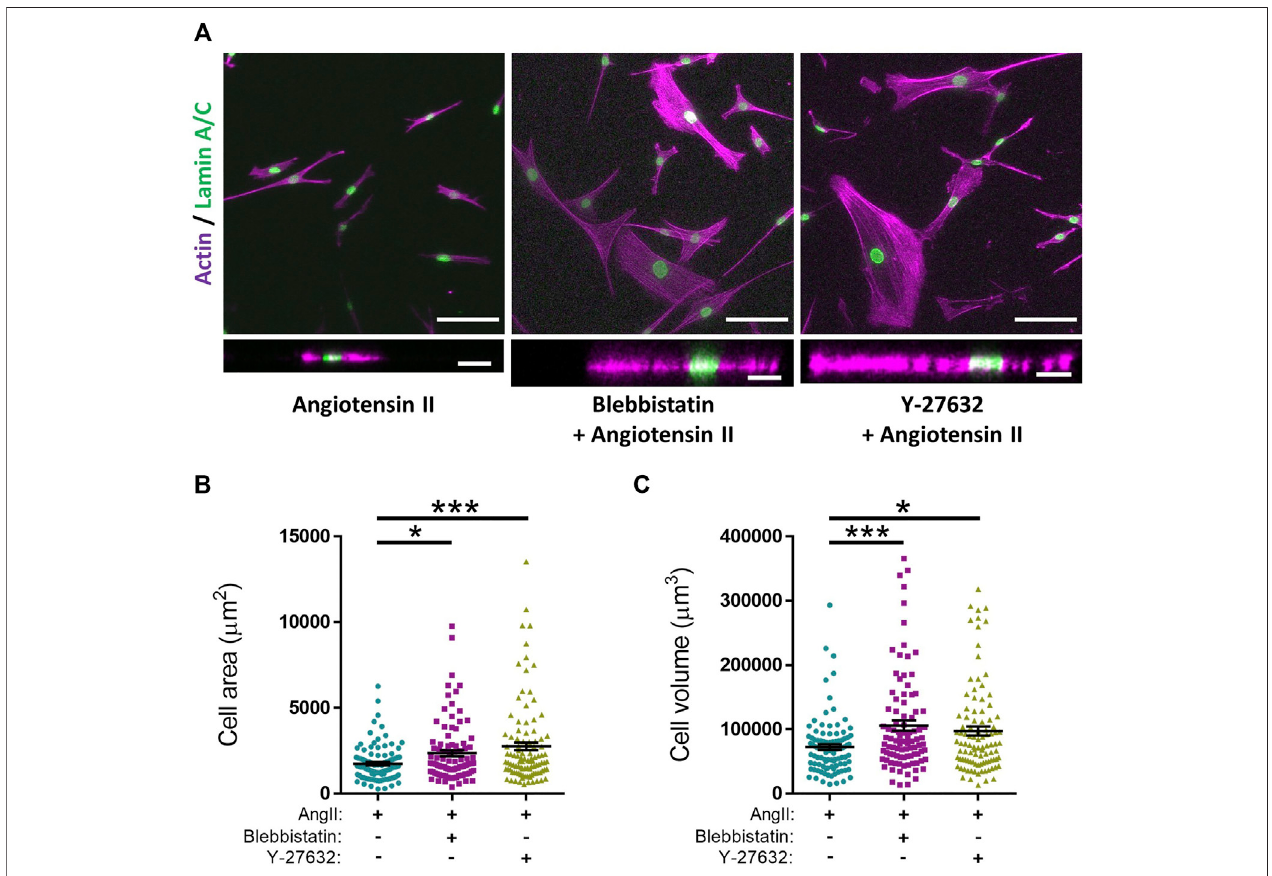
FIGURE 3 | Actomyosin inhibition prevents angiotensin II induced changes in VSMC area and increases VSMC volume on pliable hydrogels. (A) Representative imagesofisolatedVSMCsculturedon12 kPapolyacrylamidehydrogelspre-treatedwitheitherblebbistatinorY-27632for30 minpriortocotreatmentwithangiotensinII (AngII)(10 µM)foranadditional30 min. Actincytoskeleton(Rhodaminephalloidin,Purple)andLamin A/C(green). Top — RepresentativeXYimages ofVSMC area.Scale bar = 100 μ m. Bottom — Representative XZ images of VSMC height. Scale bar = 30 μ m. (B) Isolated VSMC area and (C) Isolated VSMC volume. Both (B,C)